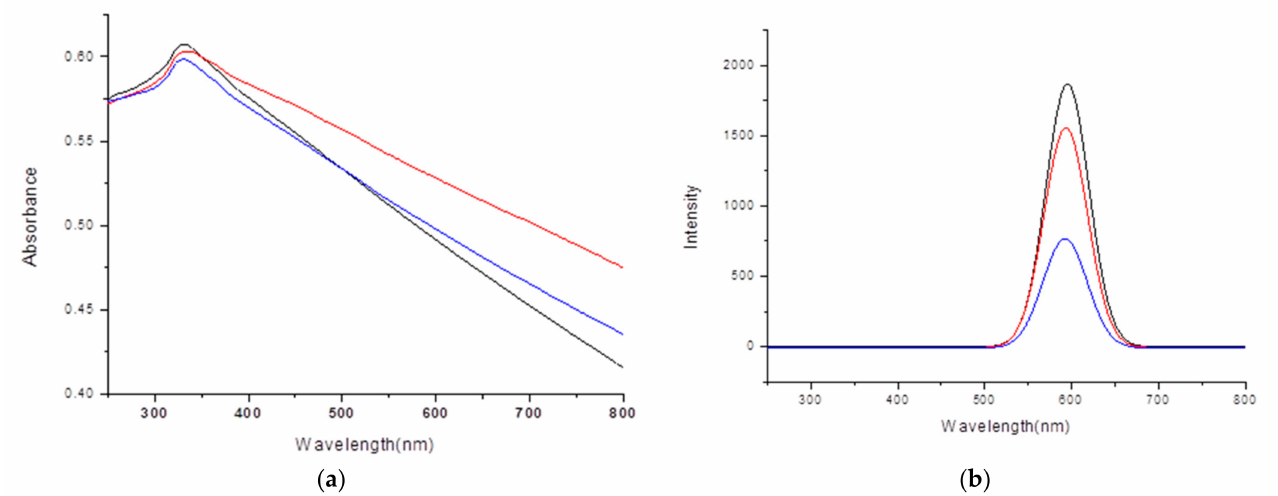
Figure 1. ( a ) UV visible absorption spectra of Gly-ZnS:Mn (black), Ala-ZnS:Mn (red), and Val-ZnS:Mn (blue) NPs. ( b ) Pho- toluminescence (PL) emission spectra of Gly-ZnS:Mn (black), Ala-ZnS:Mn (red), and Val-ZnS:Mn (blue)